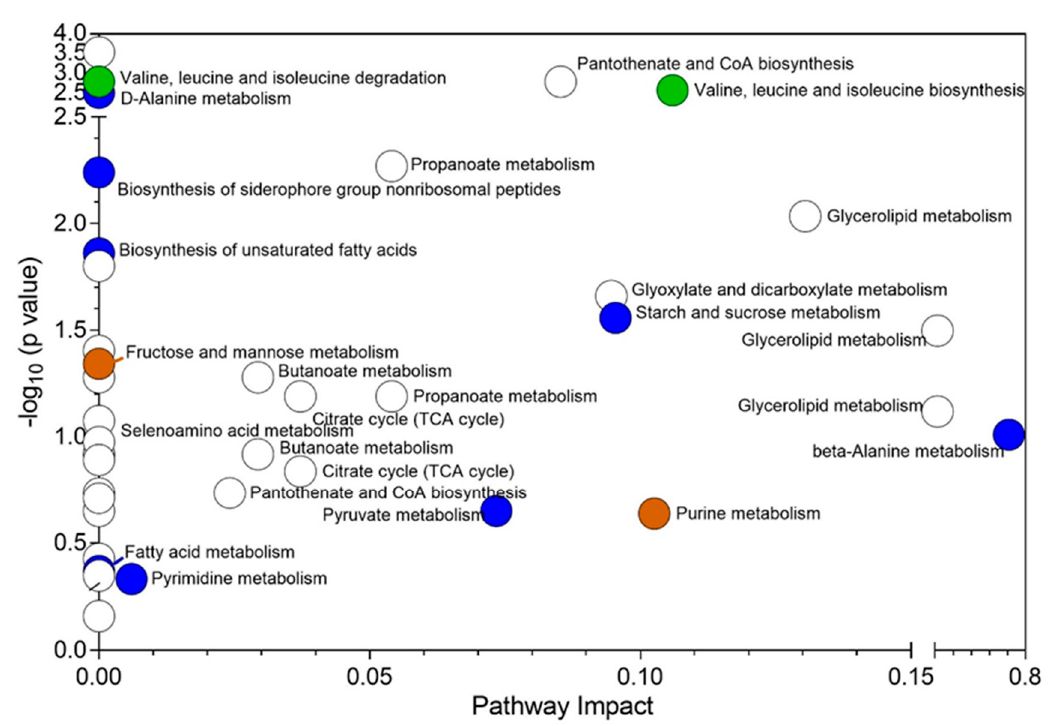
Figure 2. Metabolic pathway impact plot for Moreton Bay sediment samples based on site habitat. Note: the seagrass habitat samples were excluded from the analysis as they were under-represented in the sampling of the sites). Note: The Y-axis represents the log of the metabolite pathway significance ( p -value) and the X-axis represents calculated pathway importance post pathway topology analysis (i.e., an importance score based on each metabolite’s betweenness and degree centrality). Blue, green, and brown circles represent pathways unique to river, sandy channel, and bioturbated mud, respectively.